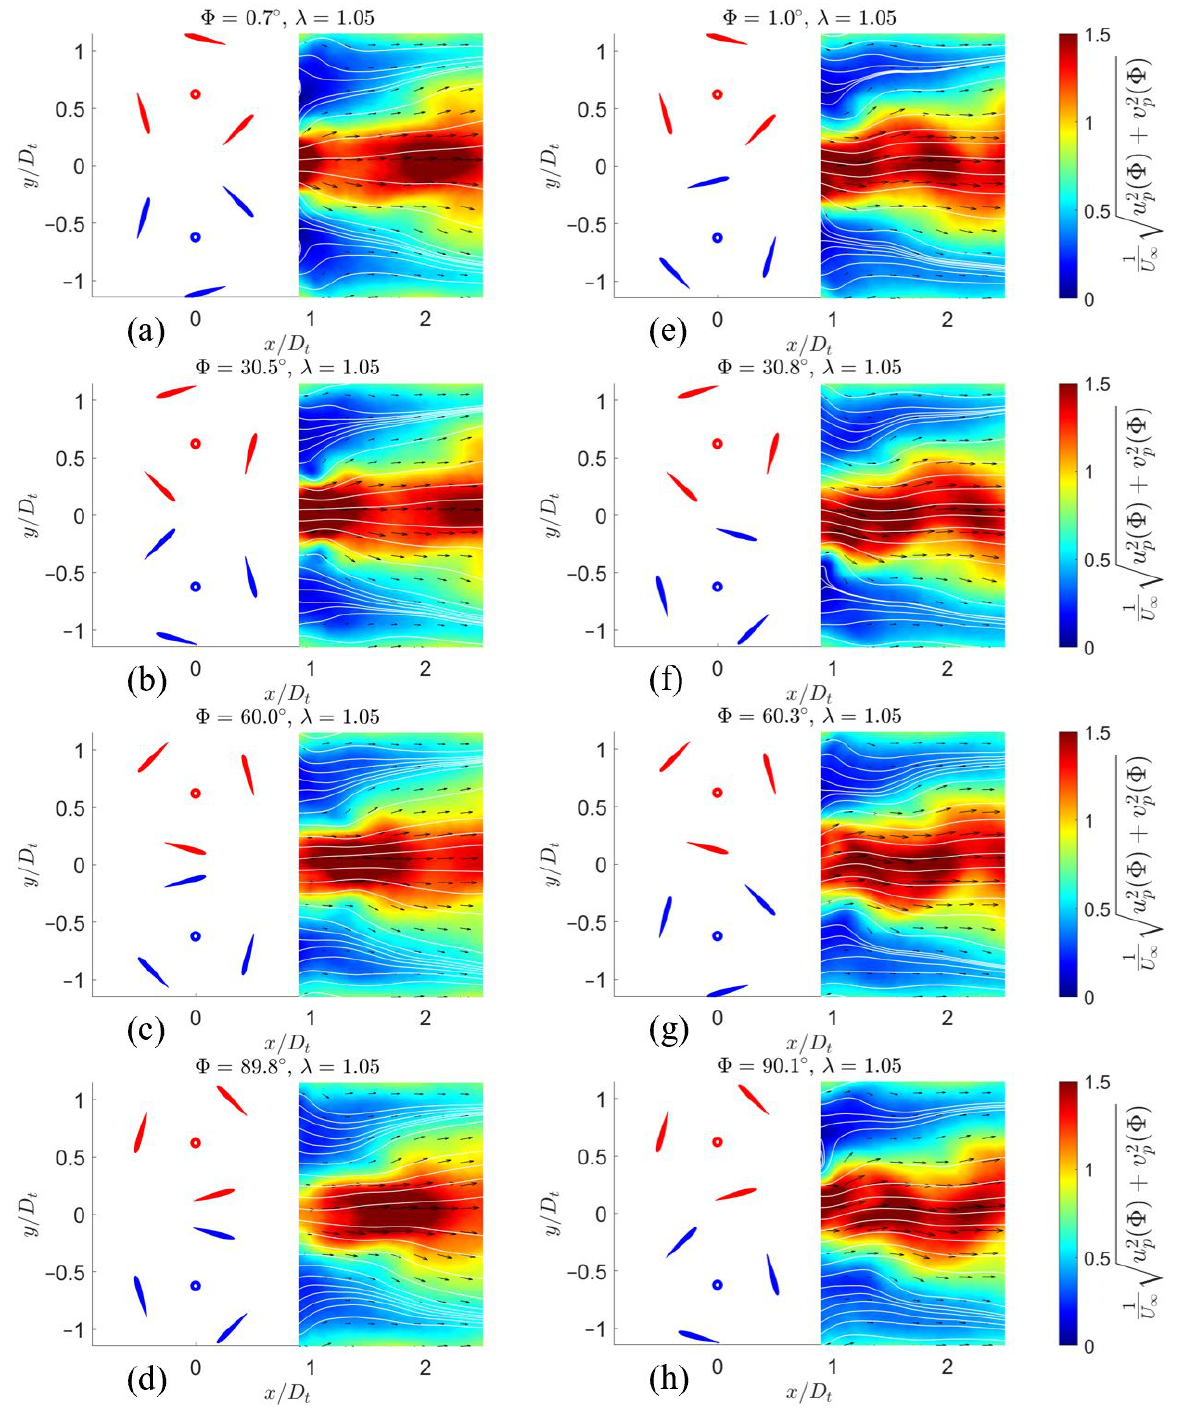
Figure 6. The phase-averaged flow fields behind the forward counter-rotating configurations at λ = 1.05. The power coefficients of these configurations are 0.116 and 0.103 for ∆Φ = 0 ◦ ( a – d ) and ∆Φ = 60 ◦ ( e – h ) correspondingly. The dis- played phase angles Φ belong to turbine T1 in red color. The color shows the non-dimensionalized phase-averaged velocity